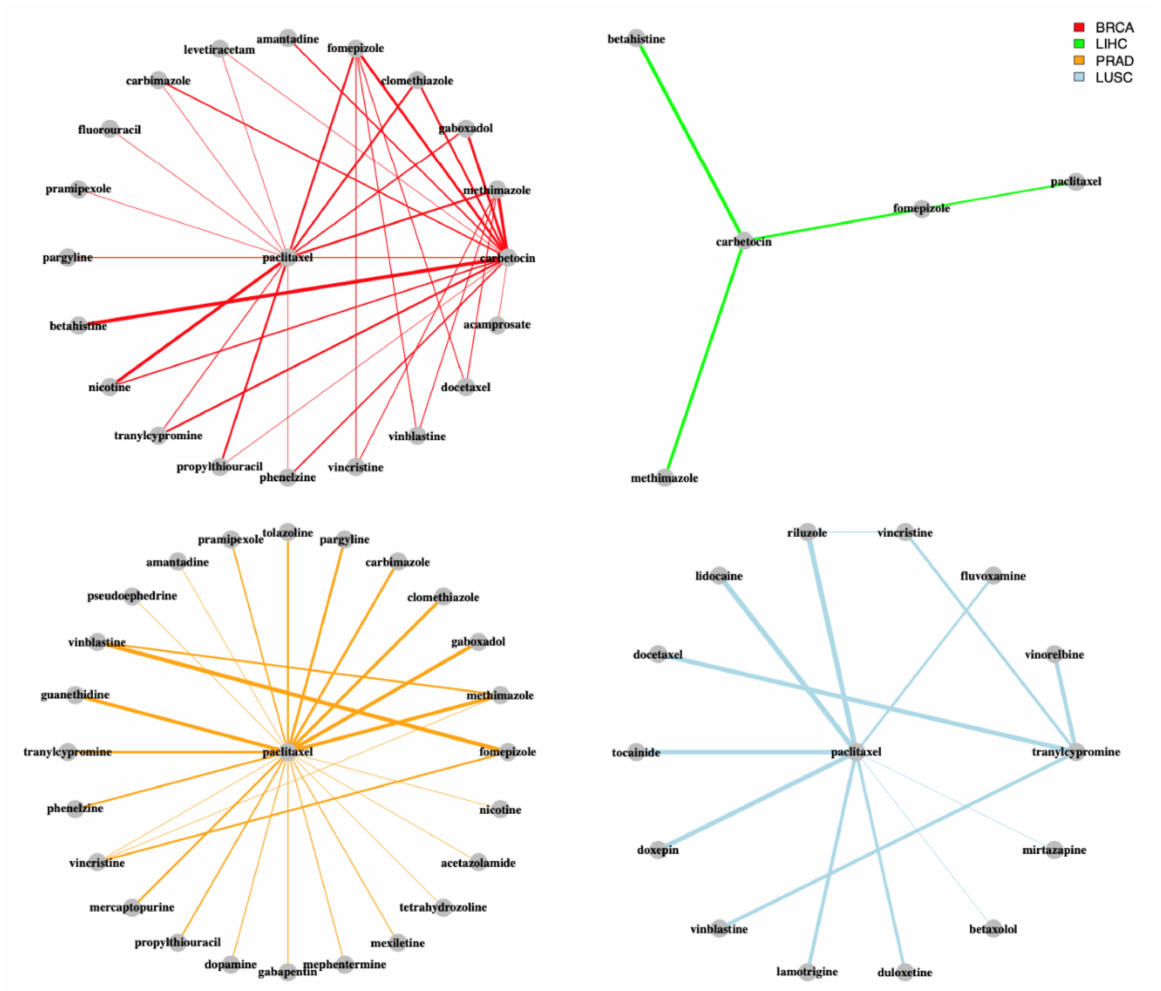
Figure 2. Network representation of the drug combinations in the considered cancers. The color of the edges indicates the cancer type. The thickness of the edges indicates the number of occurrences of the combination in the solutions of the genetic